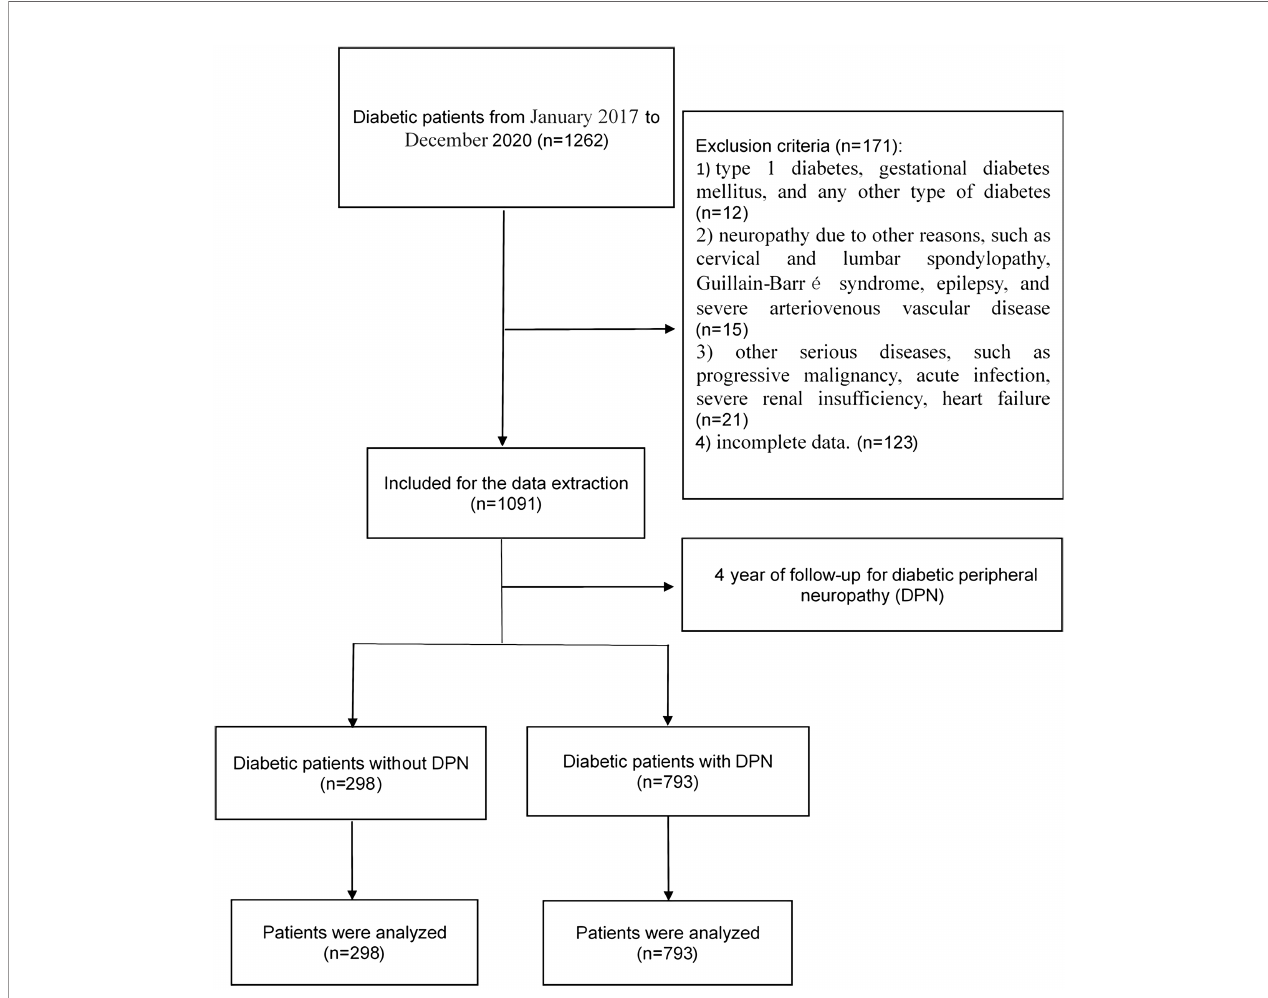
FIGURE 1 | The fl ow chart for the selection of study